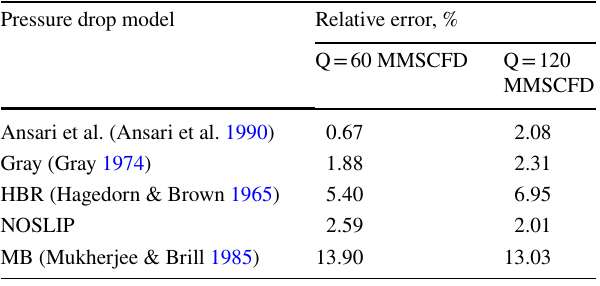
Table 9 Accuracy of tubing pressure drop models in comparison with measured data